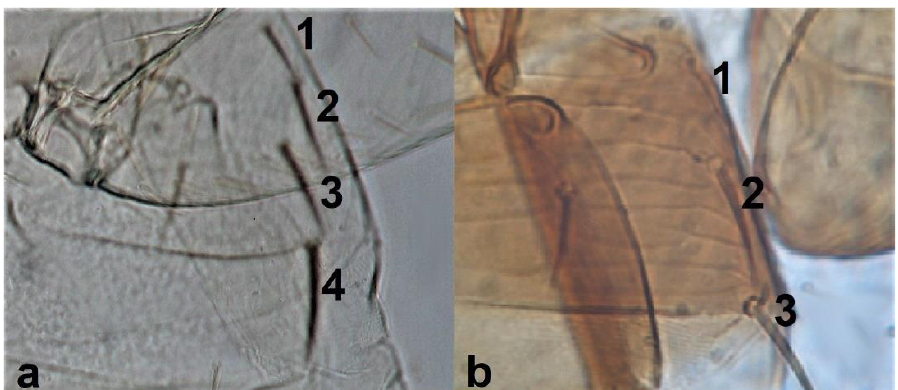
Figure 36. Abdominal tergite II ( a , b ): ( a ) with four lateral setae; ( b ) with three lateral setae . 39 Abdominal tergite VIII with microtrichial comb medially incomplete (Figure 37a)....... Abdominal tergite VIII with microtrichial comb complete (Figure 37b)